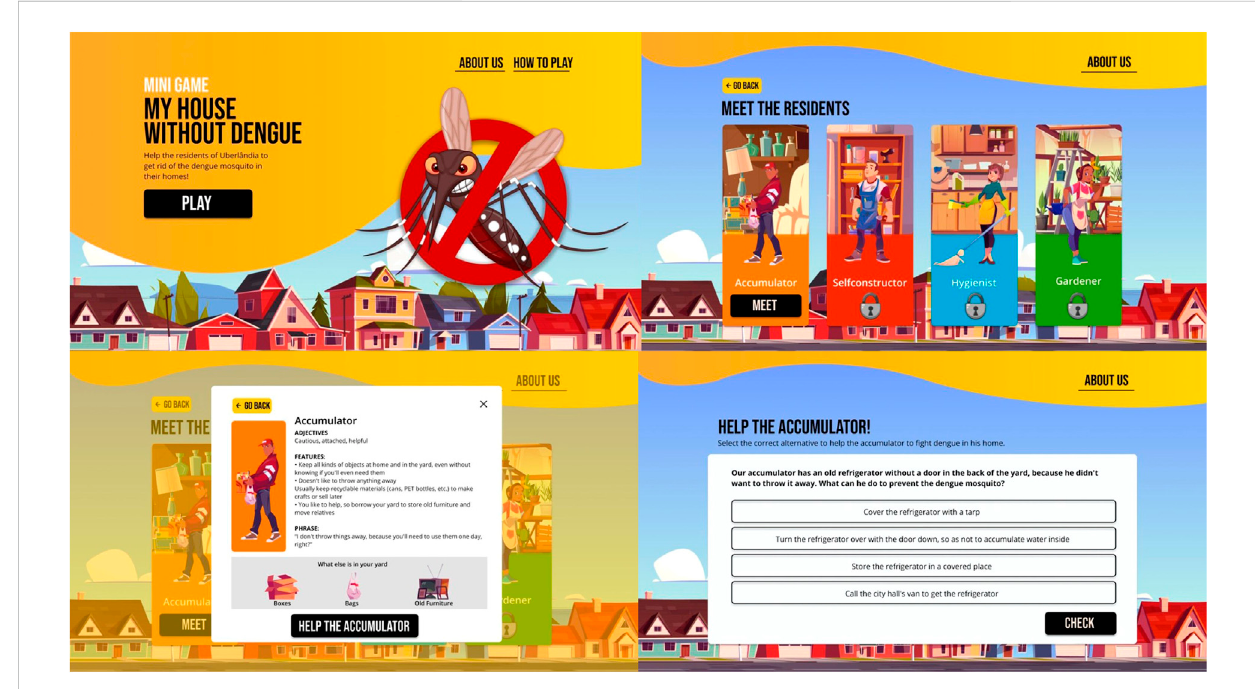
FIGURE 9 From left to rightand up to down: initial screen; “ meet the residents ” screen; character presentation example screen; and question example screen.